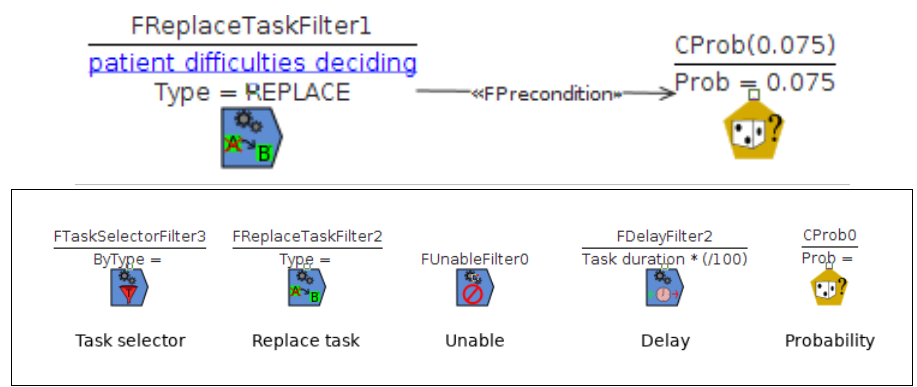
Figure 6. Forgetfulness symptom diagram.